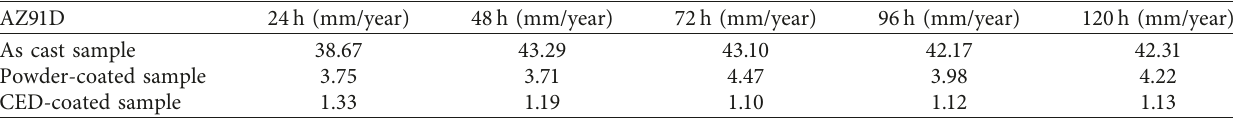
Table 7: Corrosion rate of AZ91D samples.